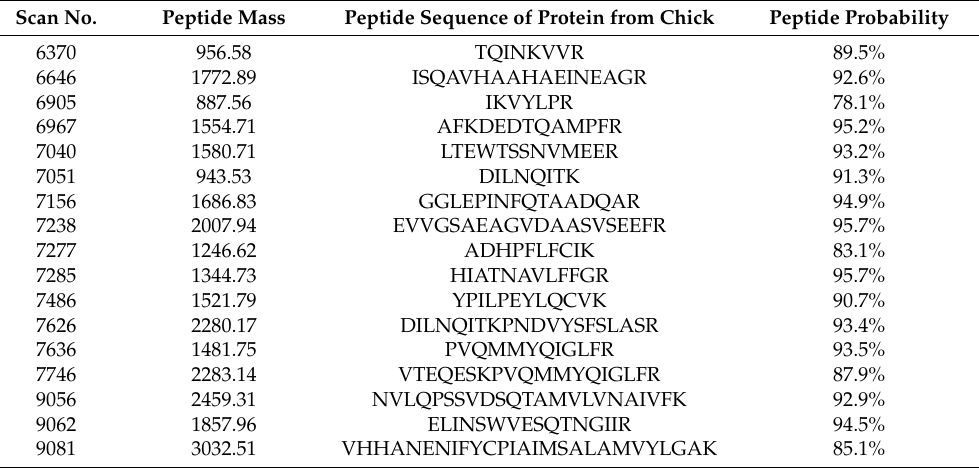
Table 6. The peptide of the OVA sample determined by Nano LC-ESI-MS/MS.